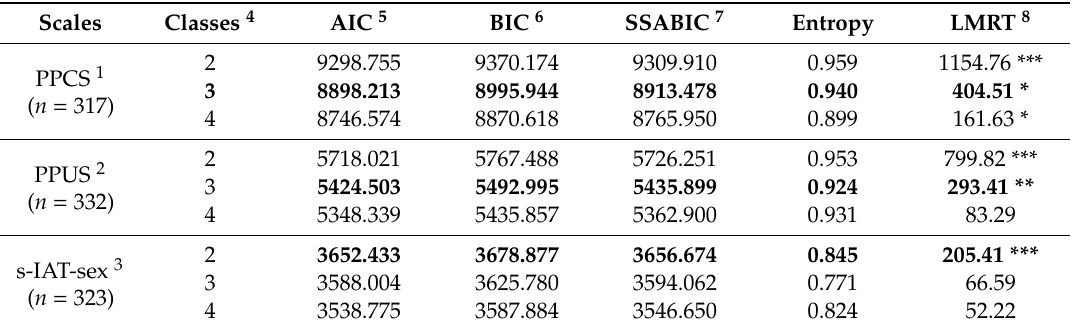
Table 3. Fit indices for latent profile analysis of the three scales assessing problematic internet pornography